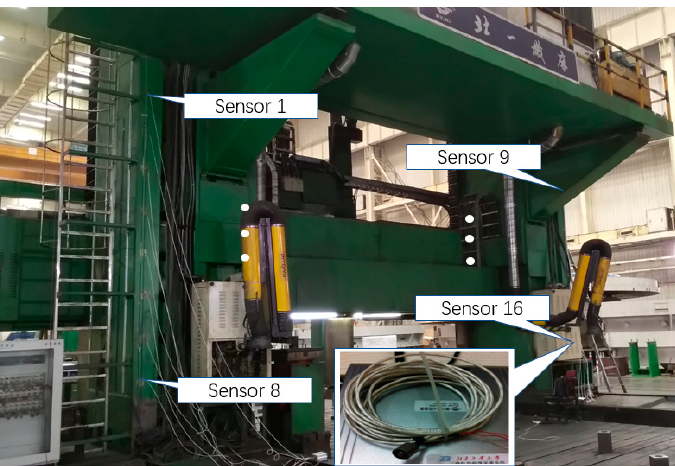
Figure 4. Overview of the sensor deployment scheme.